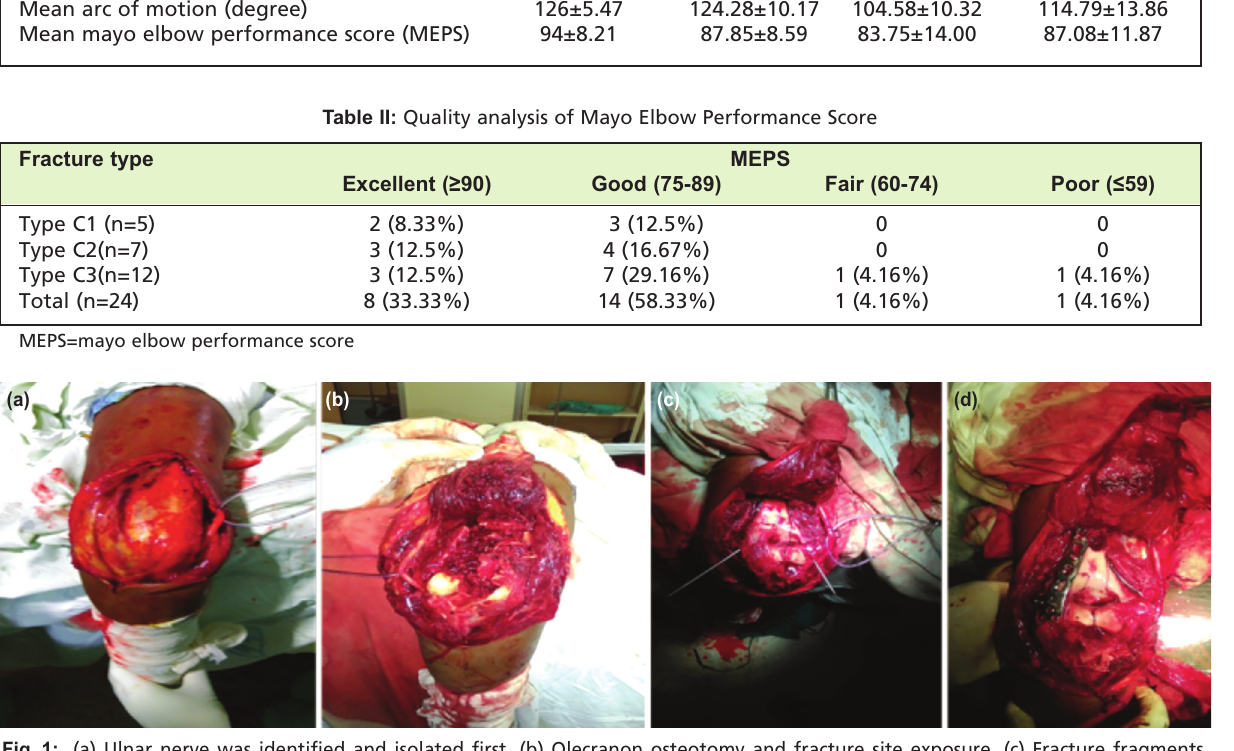
(a) Ulnar nerve was identified and isolated first. (b) Olecranon osteotomy and fracture site exposure. (c) Fracture fragments Fig. 1: reduced and temporarily held with K-wires. (d) Fracture internally fixed as per AO